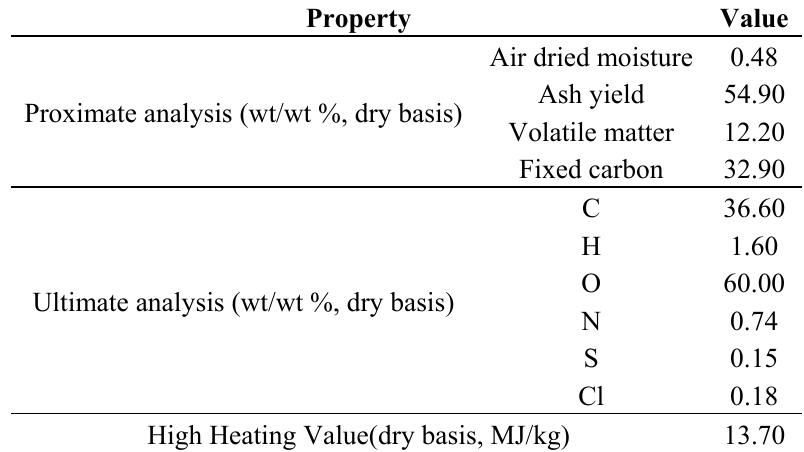
Table 7. Characteristics of the Bio-char produced from